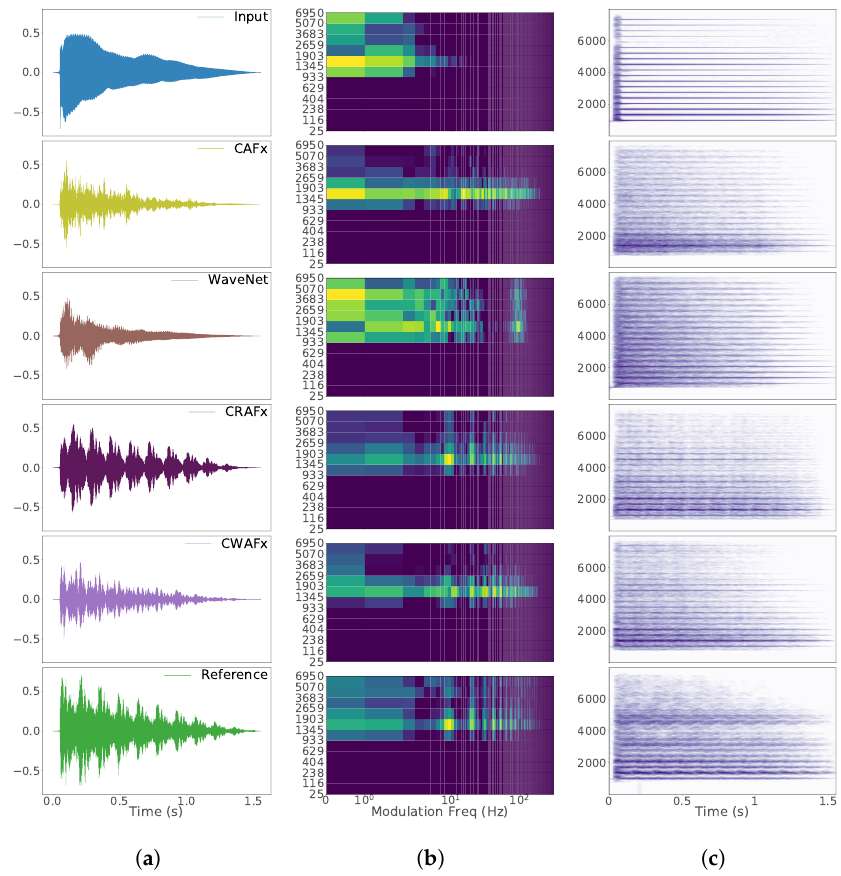
Figure 9. Results with selected samples from the test dataset for the Leslie speaker horn-tremolo tasks. ( a ) Waveform, ( b ) modulation spectrum and ( c ) spectrogram. Vertical axes represent amplitude, Gammatone frequency (Hz) and FFT frequency (Hz),